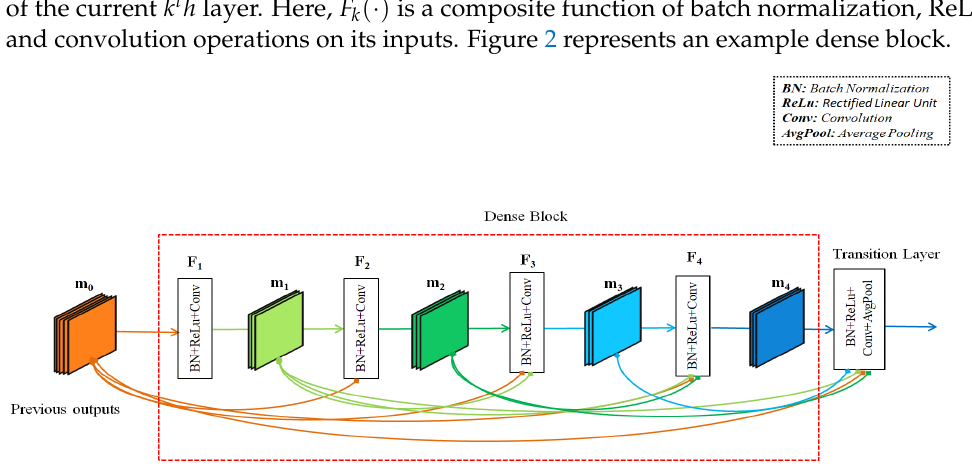
Figure 2. An example of a dense block in the DenseNet121